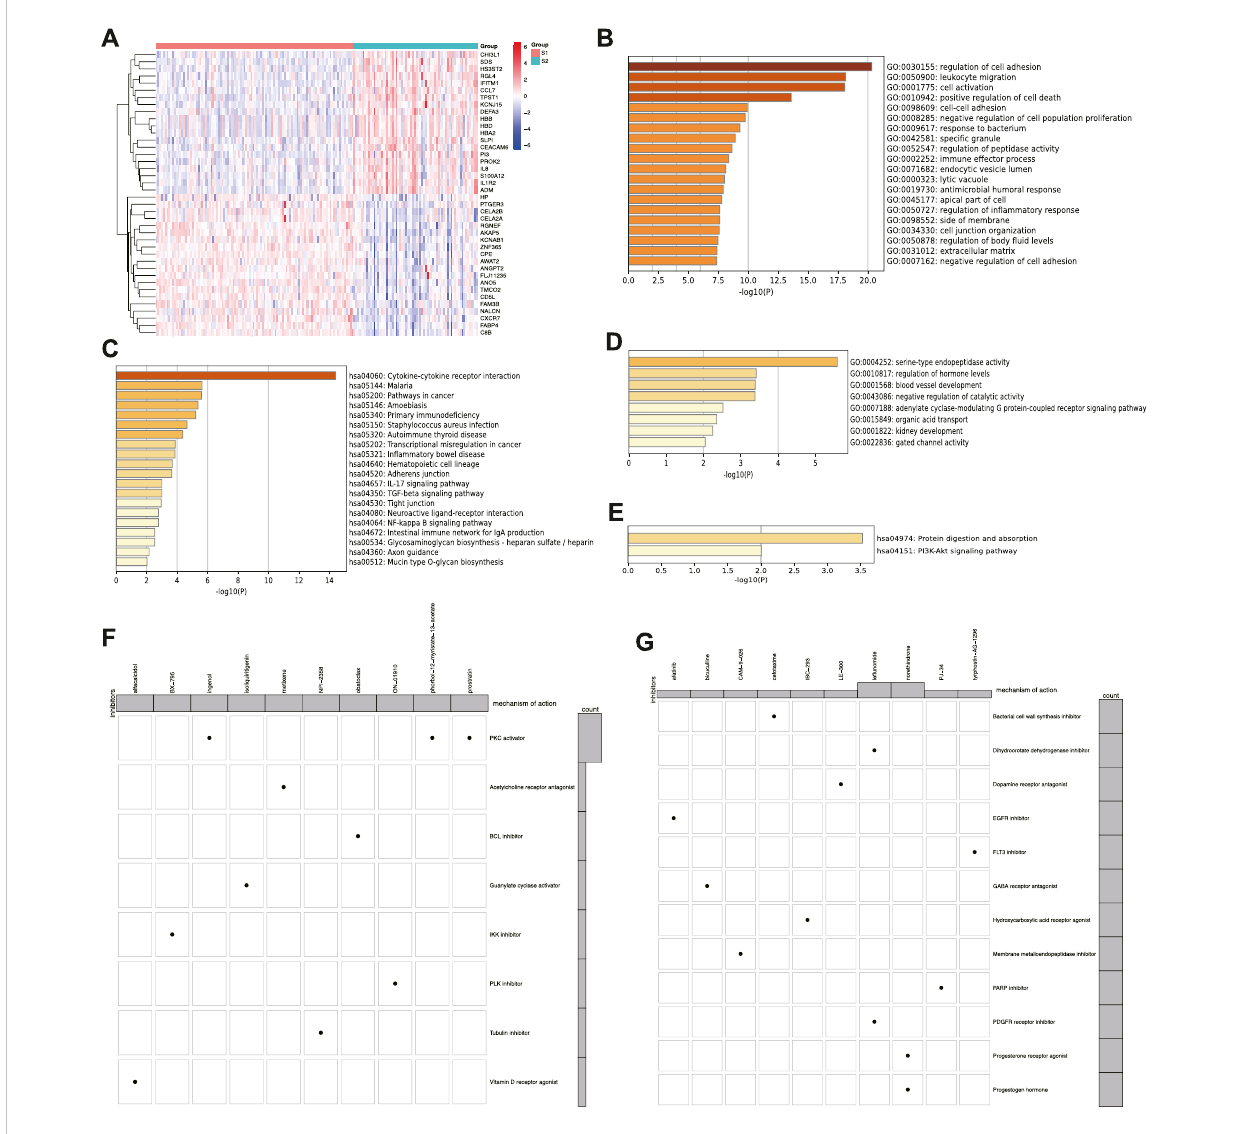
FIGURE 5 DifferentiallyexpressedgenesanddrugprobeanalysisofsenescencesubtypesofIPF. (A) Heatmapoftop20up-anddownregulatedDEGsbetween two subtypes. (B) GO and (C) KEGG enrichment analysis of upregulated genes. (D) GO and (E) KEGG enrichment analysis of downregulated genes. (F) Subtype S1 and (G) subtype S2 drug probe and possible mechanism of each